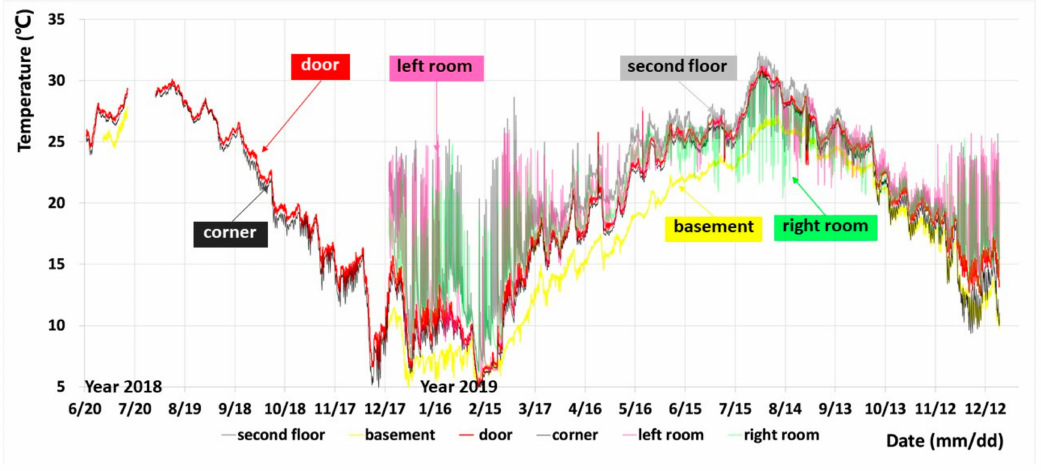
Figure 12. The measured temperatures of the o ffi ce